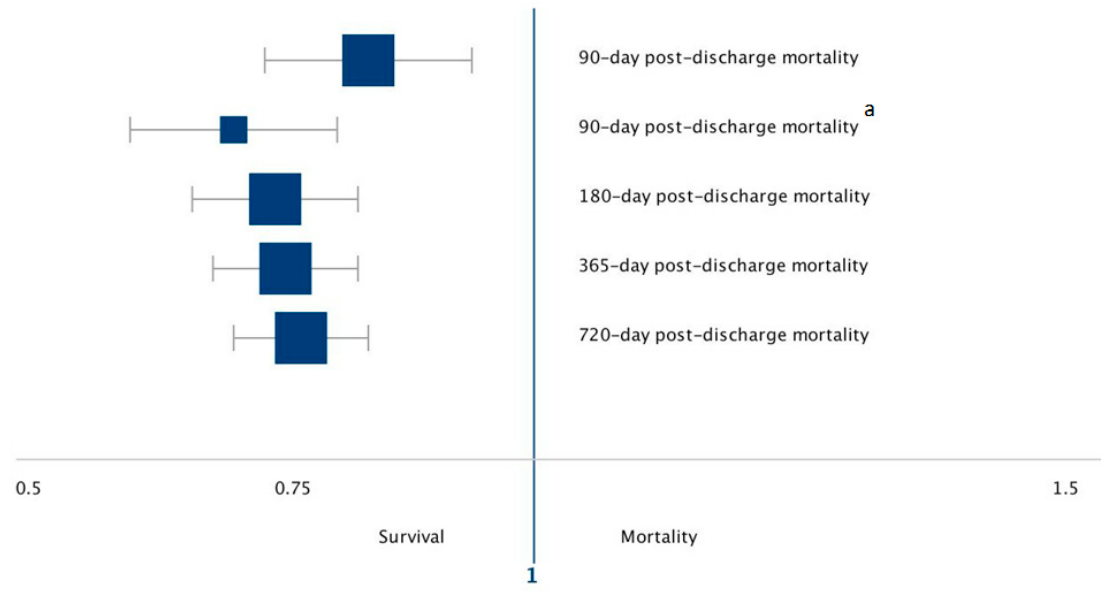
Figure 2. Forest plot of post-discharge mortality associated for each 1 g/kg/day increase in protein delivery in our study cohort. Odds ratios with corresponding 95% CIs shown of the individual outcomes under study. a Restricted to patients diagnosed with